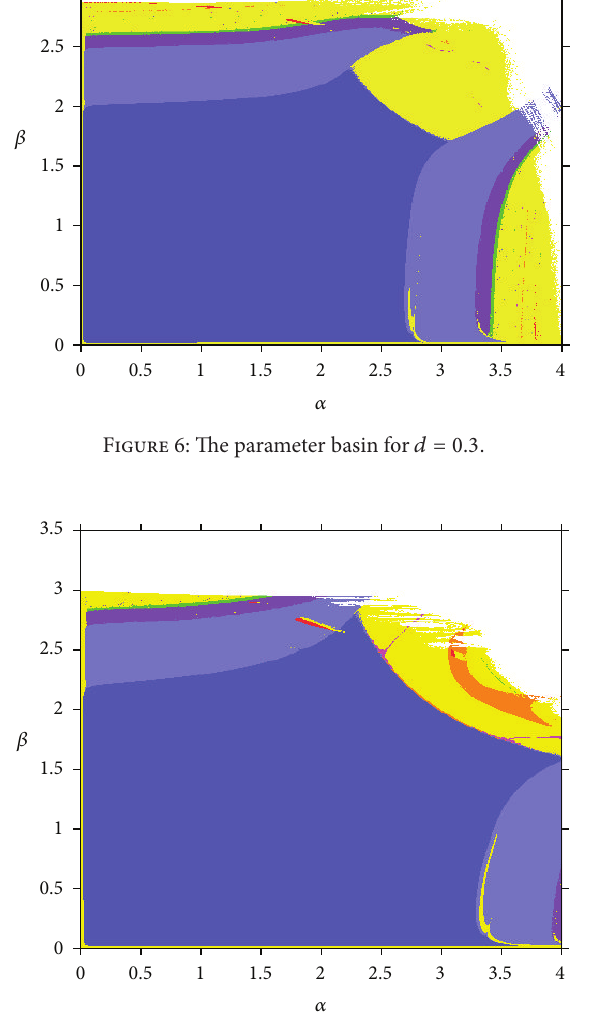
Figure 9: The parameter basin for 𝑑 = 0.9